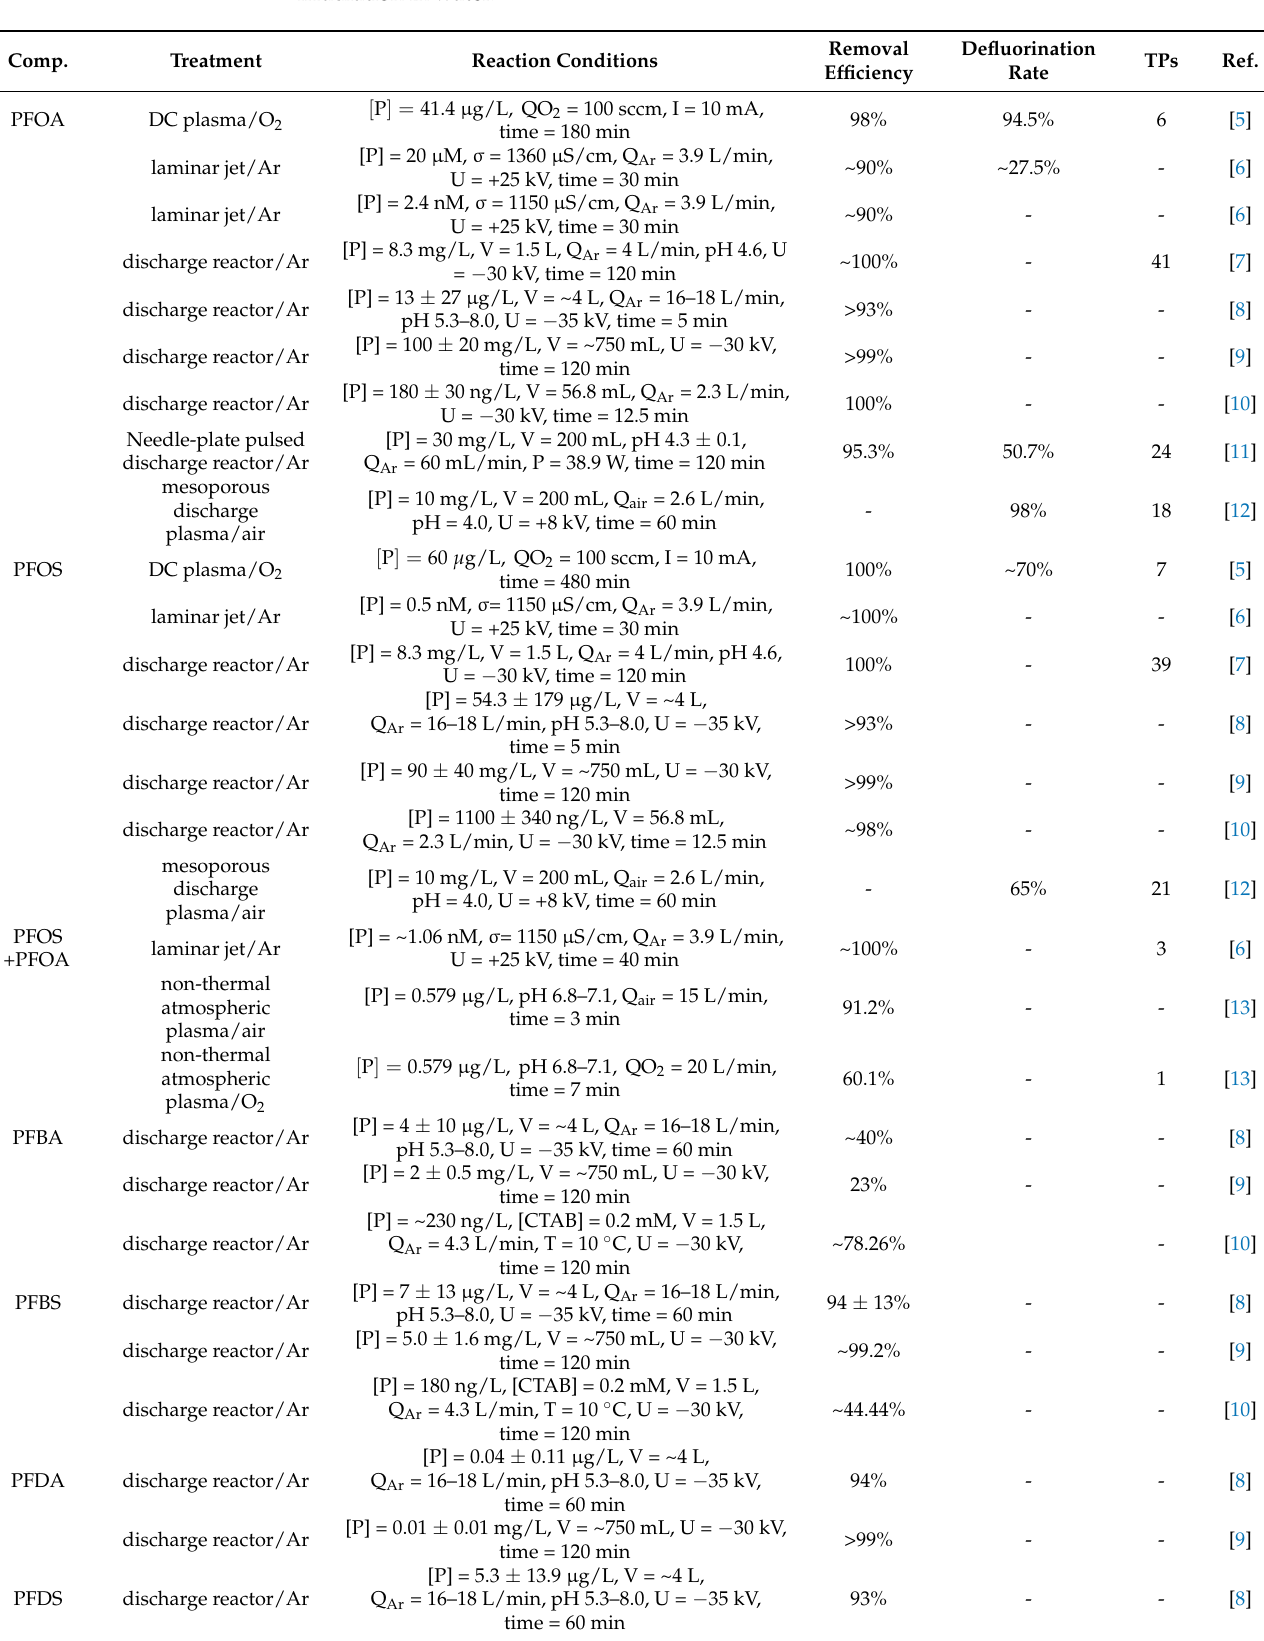
Table 2. The removal–defluorination efficiency and TP formation of PFASs after electron beam irradiation in